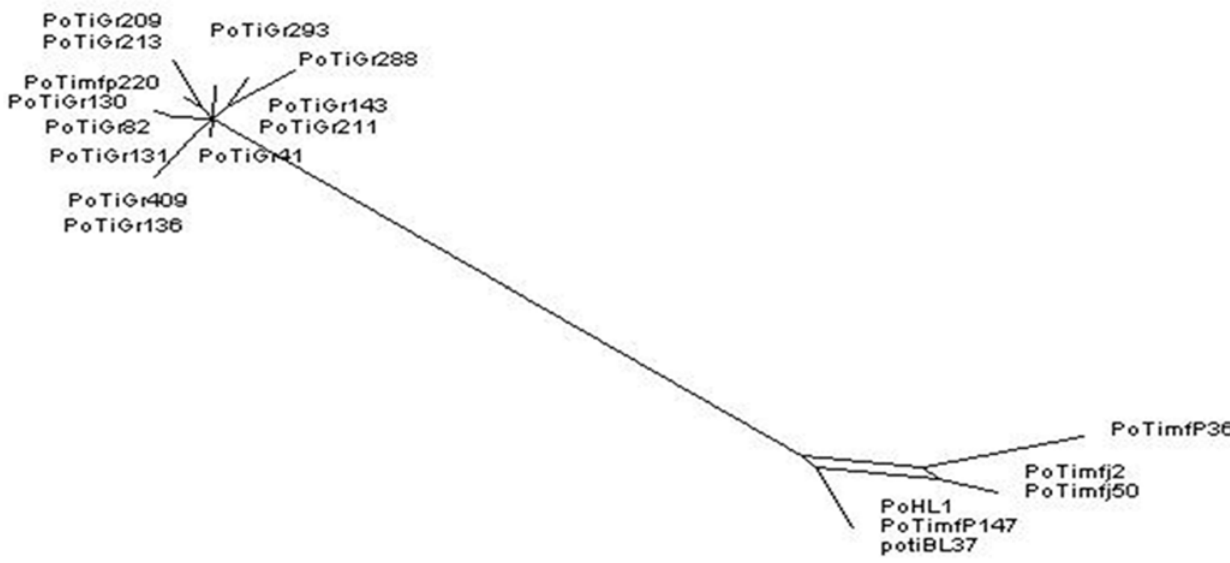
Figure 7. Network analysis. An analysis of B. lusitaniae MLST data (concatenated housekeeping gene sequences) using SplitDecomposition provided a network at the split separating the strains from Mafra which coincides with a recombination event in clpX . The two populations from Mafra and Graˆndola are well separated.